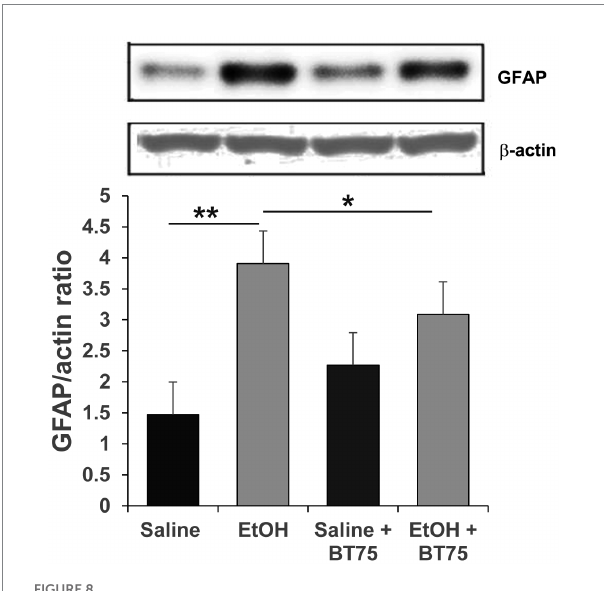
FIGURE 8 Post-ethanol treatment with BT75 attenuates P7 ethanol-induced GFAP elevation at P30. Mice were treated with BT75/vehicle (10 mg/ kg, once a day for 3 days) starting 3 days after saline/EtOH injections at P7, and the hippocampus was dissected at P30 and the ratio of GFAP/actin was measured by Western blot analyzes. BT75 significantly reduced astrocyte activation induced by EtOH. * p < 0.05, ** p < 0.001, n =